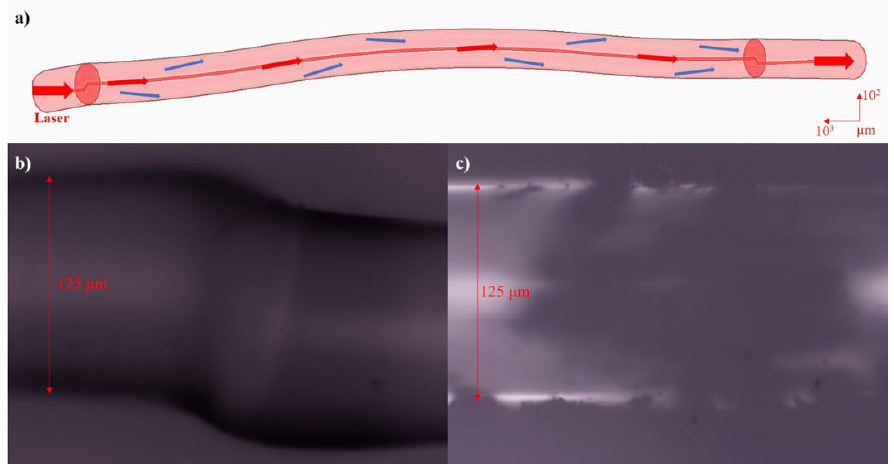
Figure 1. The schematic diagram of the mismatched single-mode fiber ( a ), the microscope image of the mismatched node ( b ) and the carbon nanotube (CNT) coated part ( c ).